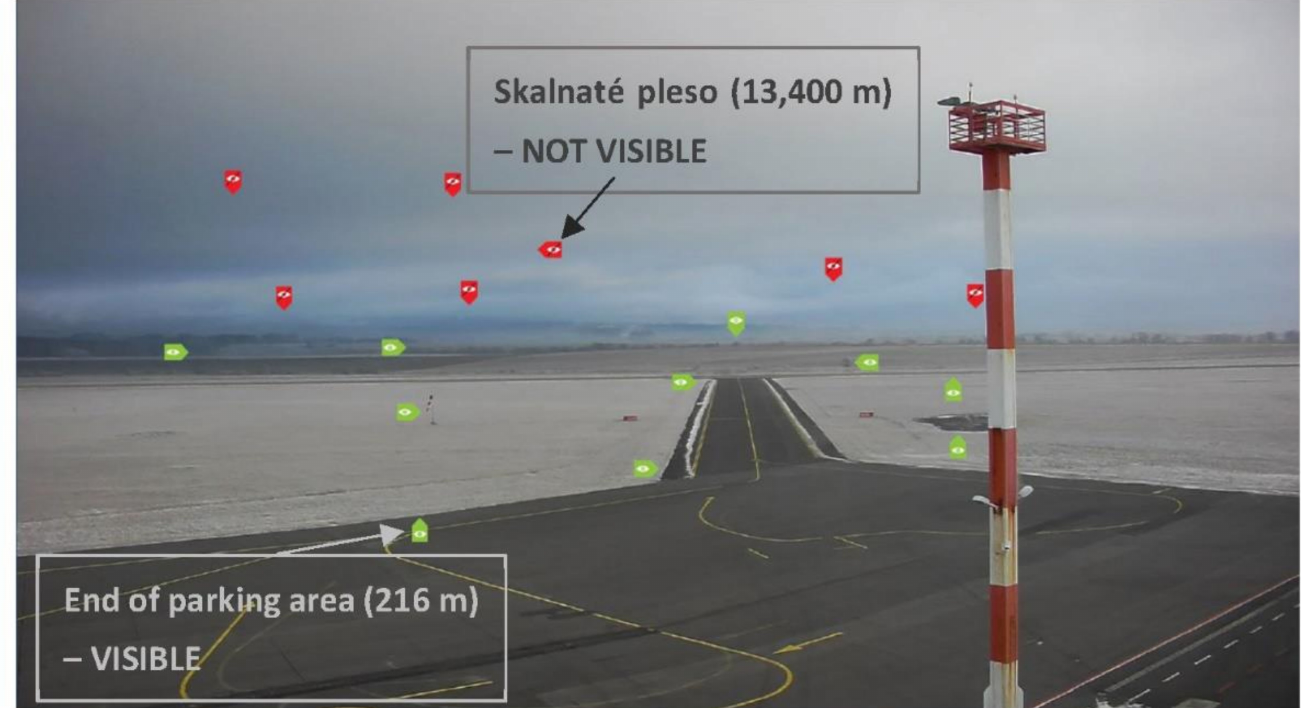
Figure 6. Adding markers to estimate the overall prevailing visibility—an example from LZTT, a view in the northern